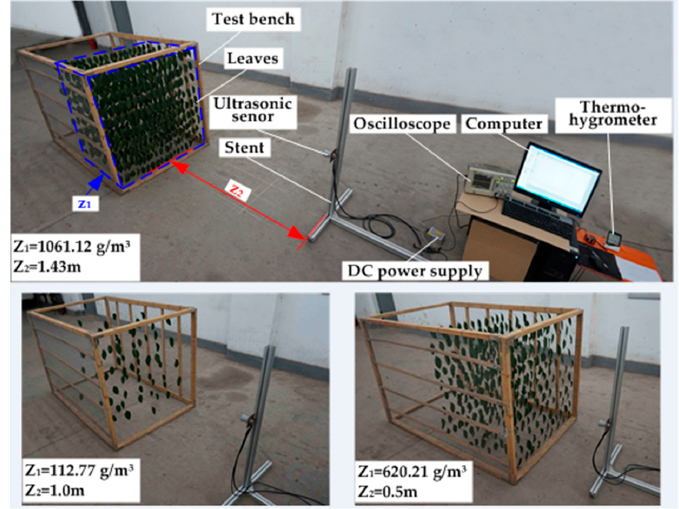
Figure 5. Canopy model experiments performance with four layers of leaves.